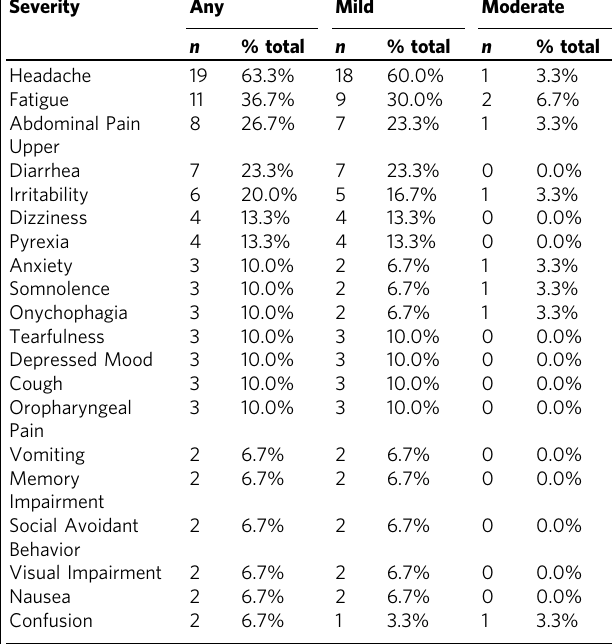
Table 3 Treatment Emergent Adverse Events